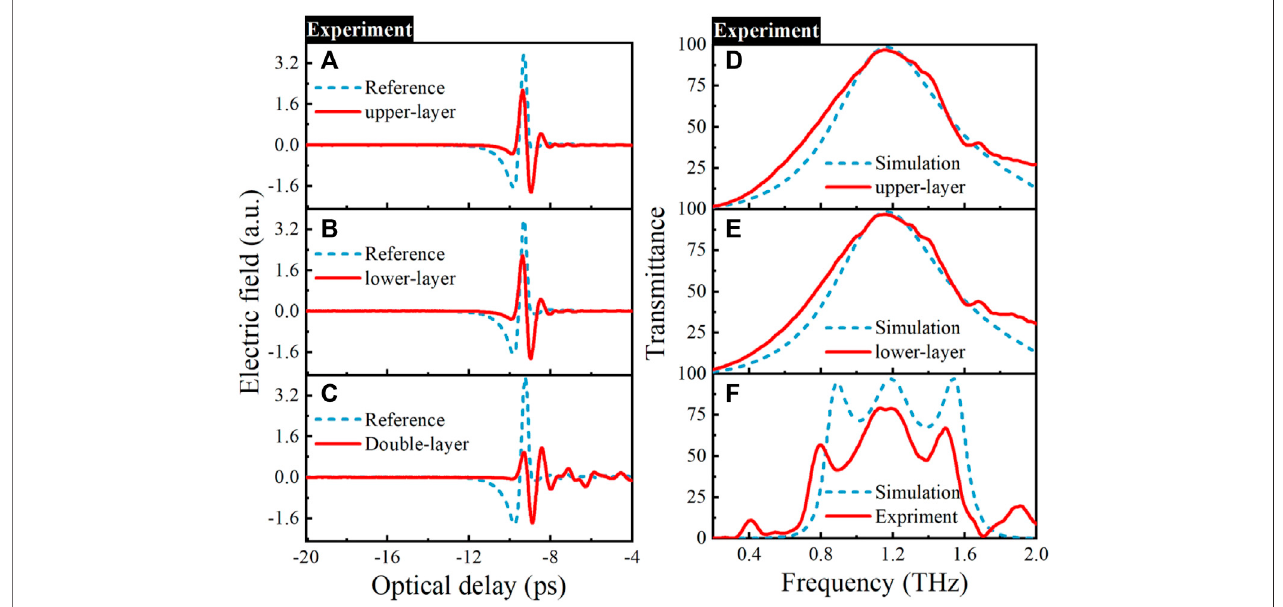
FIGURE 7 | Experimental THz time-domain signal (red solid lines) and reference signal (blue dash lines) for the structure of upper layer (A) , lower layer (B), and doublelayer (C) .Experimental transmittancespectraofthemonolayer fi lter (D,E) andtheproposeddoublelayermetamaterial fi lter (F) obtainedbyusingsimulation(blue dash lines) and experiment (red solid lines).